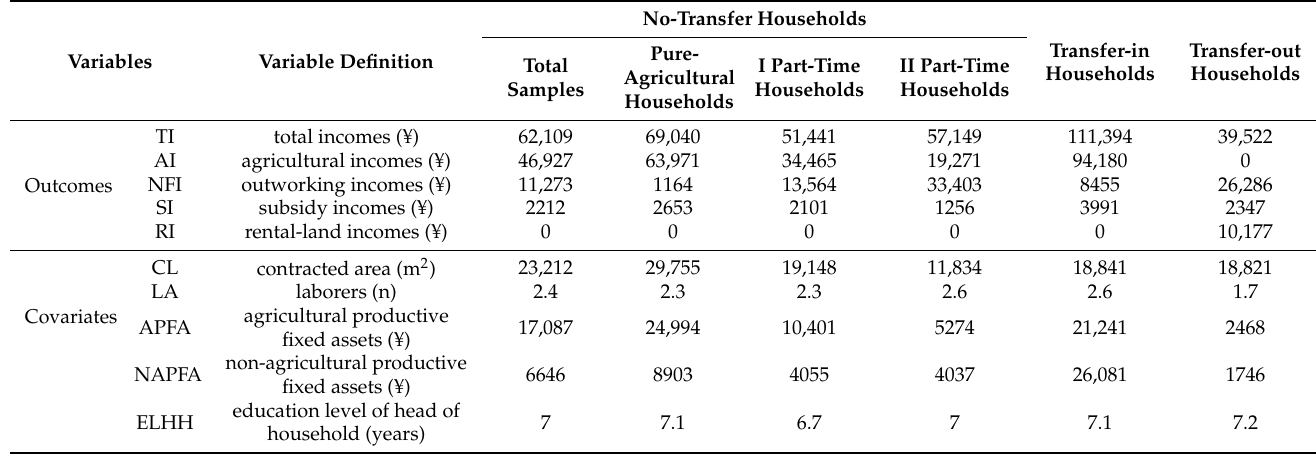
Table 1. Descriptive statistical characteristics of